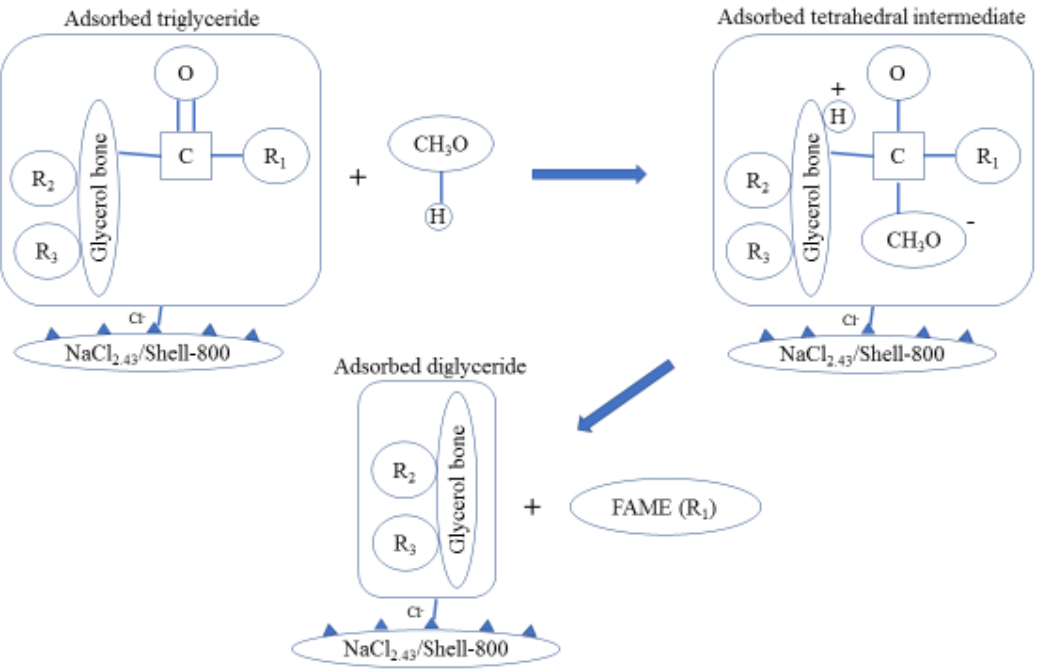
Figure 6. Role of NaCl 2.43 /Shell ‐ 800 surface basic site on the improved activity.